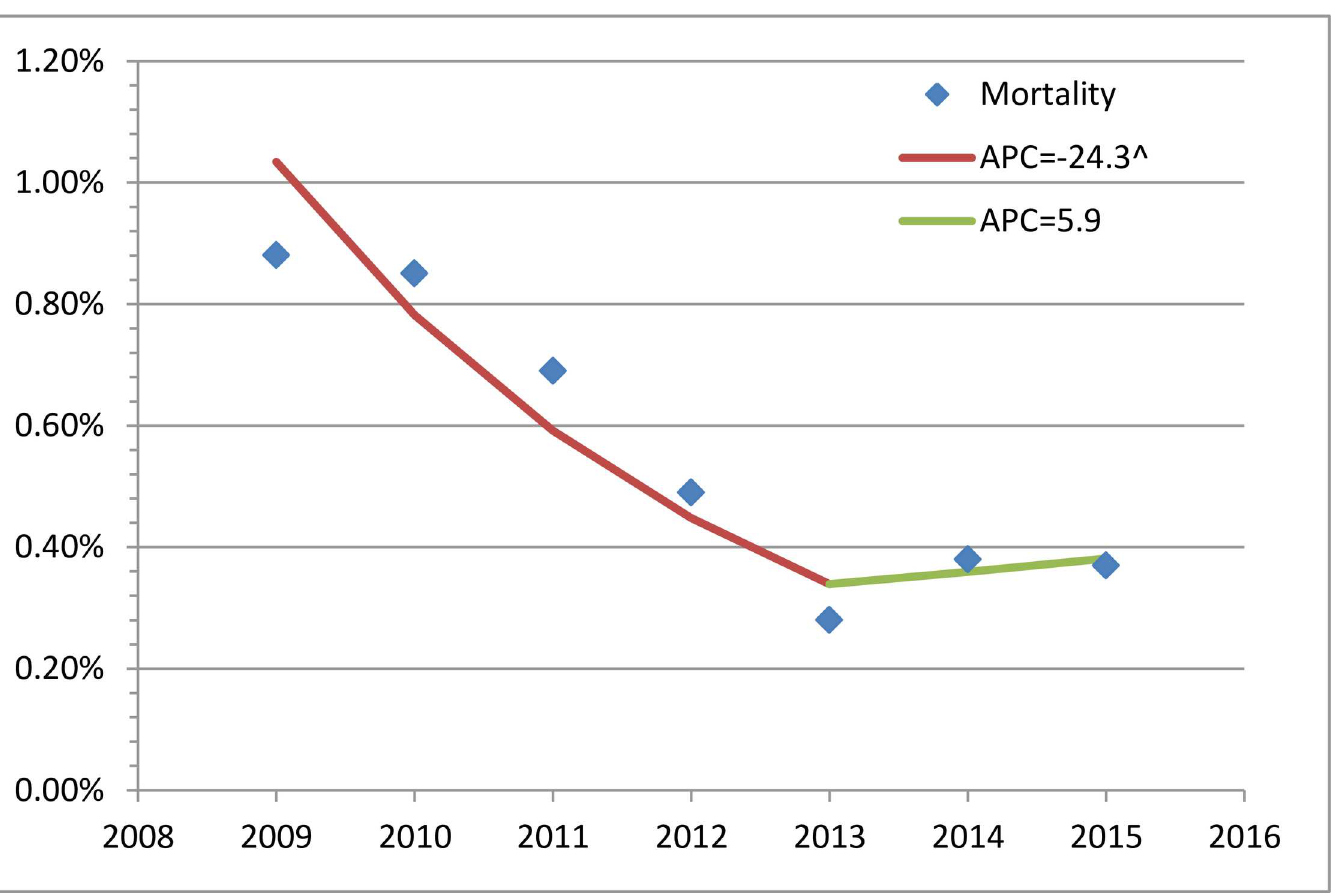
Fig 1. Trends in the outpatient and inpatientservicesof JishuitanHospital at Xinjiekou campus,Beijing,China(JST)and tertiaryhospitalsof Beijing,China(BJT). ^: a significant trendidentified( P < 0.05);APC: Annual percentagechange;RMOH:Ratio medicine over health charges. Physician workloads: average annual patient-visit numberper day for outpatientserviceand average patient-bed numberper day for